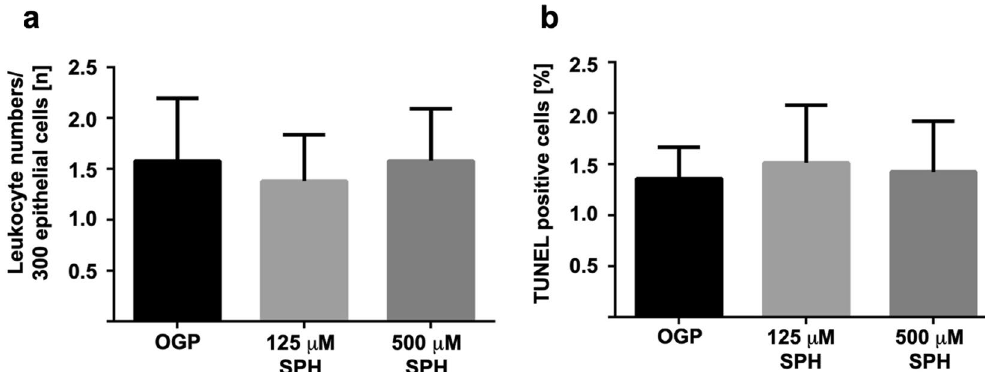
Figure 4. ( a , b ) Leukocyte numbers/300 epithelial cells ( a ); TUNEL positive cells ( b ). No higher incidence of cell death or leukocyte influx in bronchial epithelial cells was observed after inhalation of sphingosine. Hemalaun staining was performed for paraffin sections from bronchial biopsies from EVLP minipig lungs that were inhaled with 125 µM sphingosine (SPH), 500 µM sphingosine (SPH) or with octylglucopyranoside (OGP) as control. Three sections with 5 visual fields were analyzed for each lung and leukocyte numbers per 300 epithelial cells were counted. TUNEL reaction was performed for paraffin sections from bronchial biopsies from EVLP minipig lungs that were inhaled with 125 µM sphingosine (SPH), 500 µM sphingosine (SPH) or with octylglucopyranoside (OGP) as control. Statistical analysis of leukocyte influx and TUNEL positive cells after inhalation of octylglucopyranoside (OGP), 125 µM (125 µM SPH) or 500 µM (500 µM SPH) sphingosine containing 5 ml suspension did not reveal a statistically significant difference. Given are numbers of leukocytes/300 epithelial cells (n) and percentage of TUNEL positive cells from 3 sections with 5 visual fields per animal (blinded tests), Given are mean ± SD,